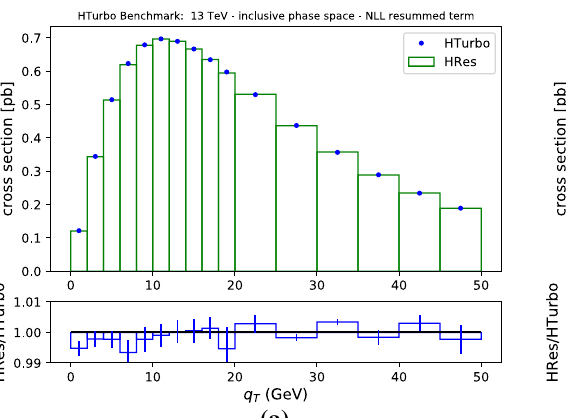
√ s = 13 TeV. Resummed